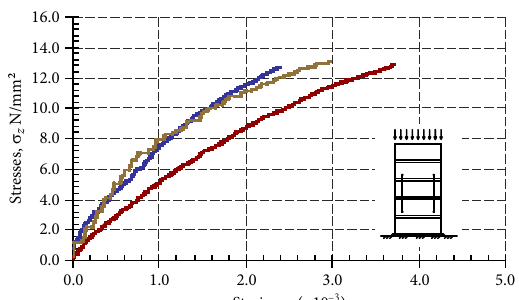
Fig. 12. The dependence of the Serial B6 masonry specimens stress under the short-term load